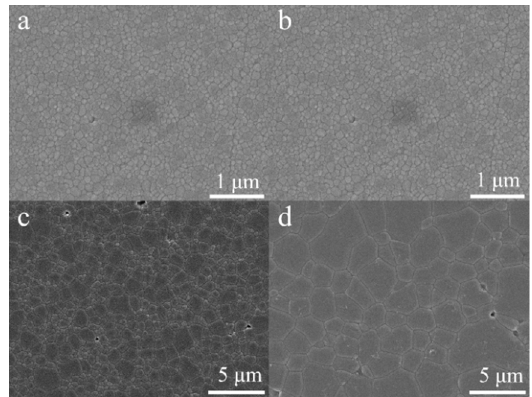
Figure 9. FESEM images of the etched surface of HA pellets sintered at 1000 °C ( a ); 1100 °C ( b ); 1200 °C ( c ); and 1300 °C ( d ). Note the differences in magnification. Micrographs ( a ) and ( b ) were taken at 25,000×. Micrographs ( c ) and ( d ) were taken at 5000×.